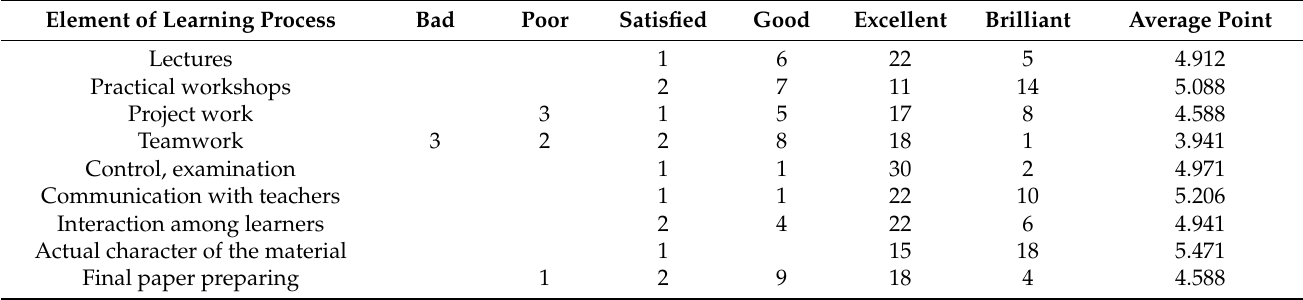
Table A3. Points awarded by students on the elements of the organization of the educational process, December 2020 (N3 = 34). Element of Learning Process